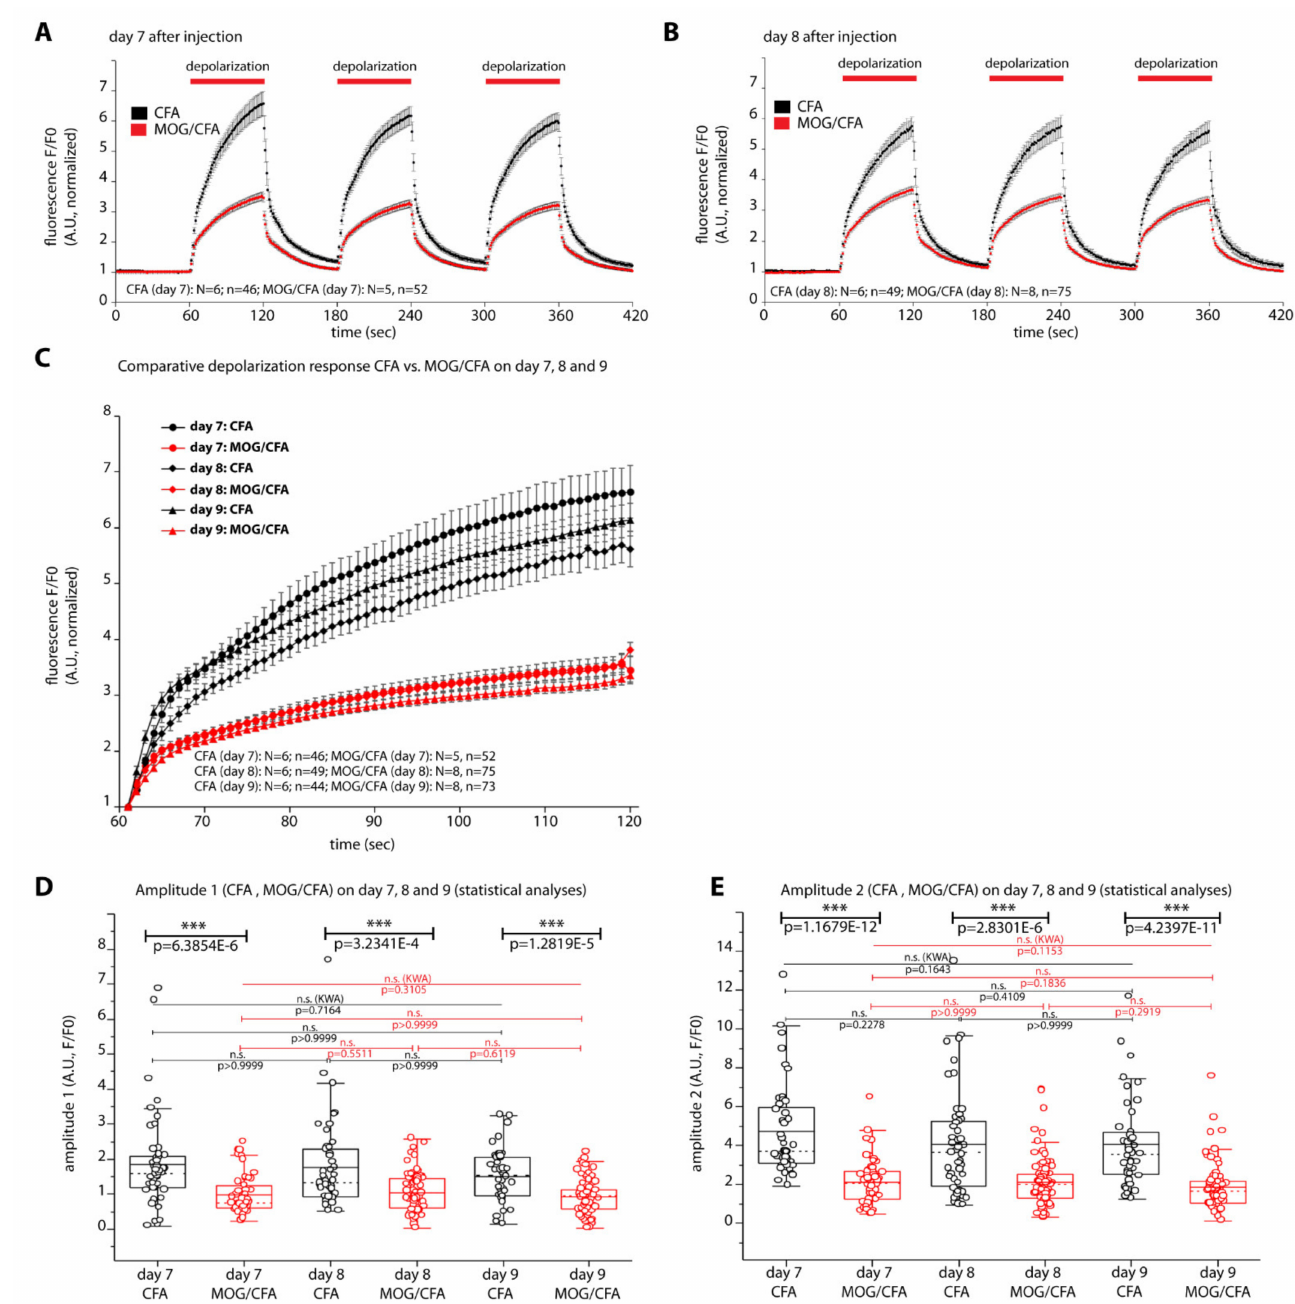
Figure 7. Synaptic vesicle exocytosis in EAE mice is compromised as early as on day 7 after injection. Exocytosis was analyzed by optical recording of SypHy responses, as described (Dembla et al., 2018) at the indicated days after injection. ( A , B ) K + -depolarization-evoked SypHy responses in the OPL of MOG/CFA-injected EAE mice and CFA-injected control mice on day 7 and day 8 after injection. ( C ) Comparison of depolarization-evoked responses between CFA-injected